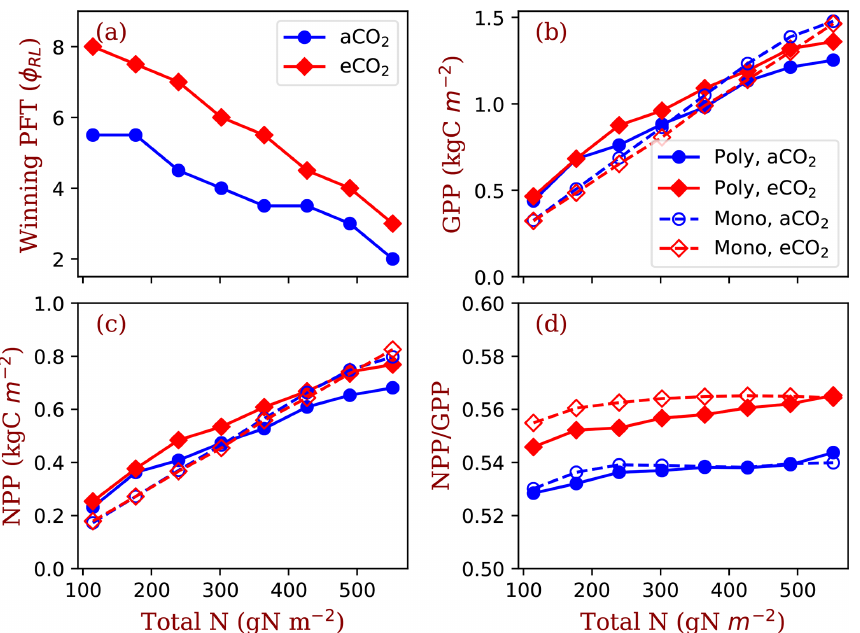
Figure 5. Winning PFTs ( ϕ RL , a ) in polyculture run II and equilibrium gross primary production (GPP, b ), net primary production (NPP, c ) and carbon use efficiency (NPP / GPP, d ) at two CO 2 concentrations ( a CO 2 : 380ppm; e CO 2 : 580ppm). The closed symbols with solid lines represent polyculture runs. The open symbols with dashed lines represent monoculture runs (only ϕ RL = 4 shown in this figure). ϕ RL is the fixed ratio of fine root area to leaf area of a particular